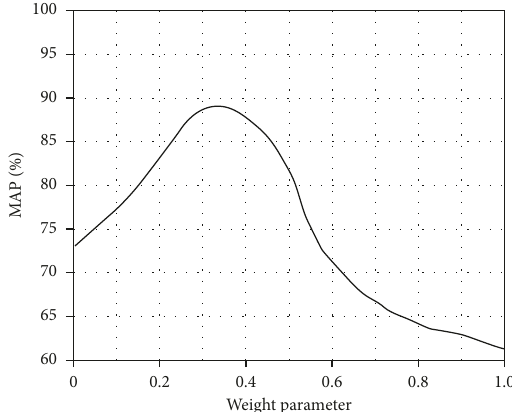
Figure 6: Weight parameter